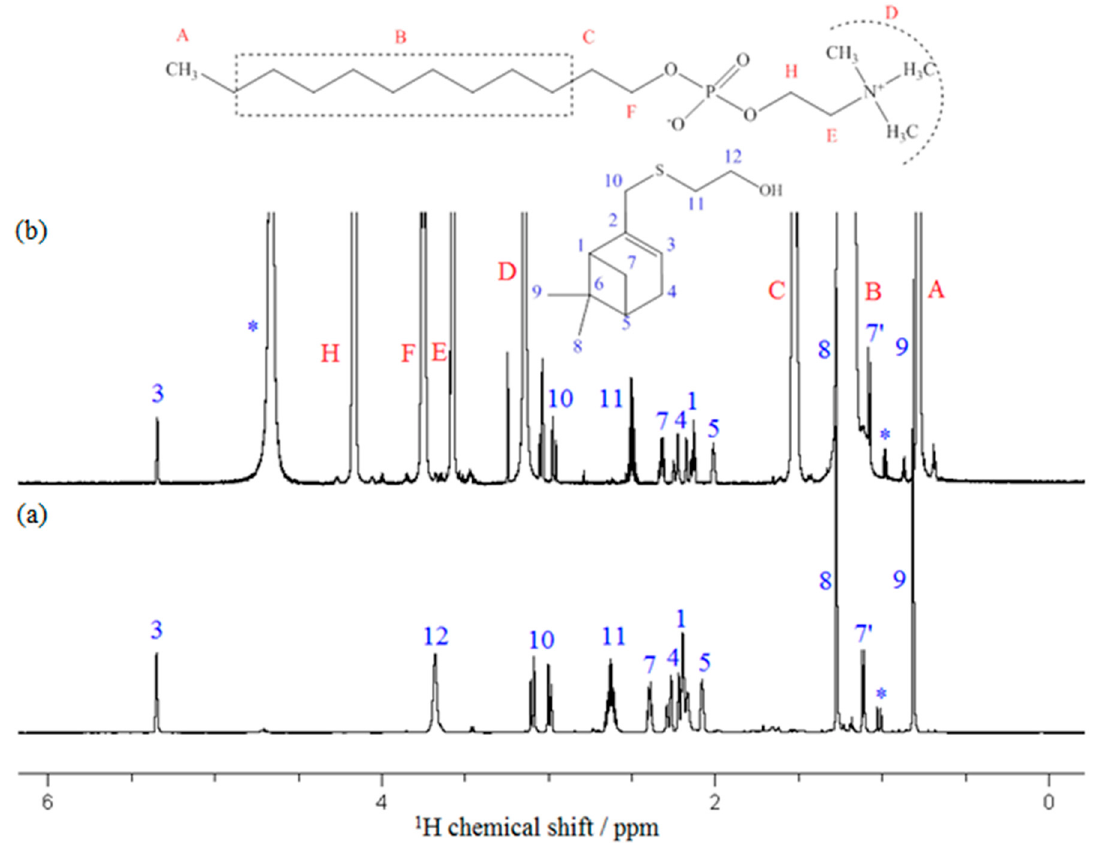
Figure 5. The 1 H NMR spectra of compound 4 in CDCl 3 ( a ) and D 2 O+DPC ( b ) solutions at 300 K. Numbers designate protons of compound 4 , letters A–H corresponds to DPC protons. The chemical structures of the DPC molecule and compound 4 are shown on the top of the figure. The solvent and impurity signals are marked by asterisks (*).